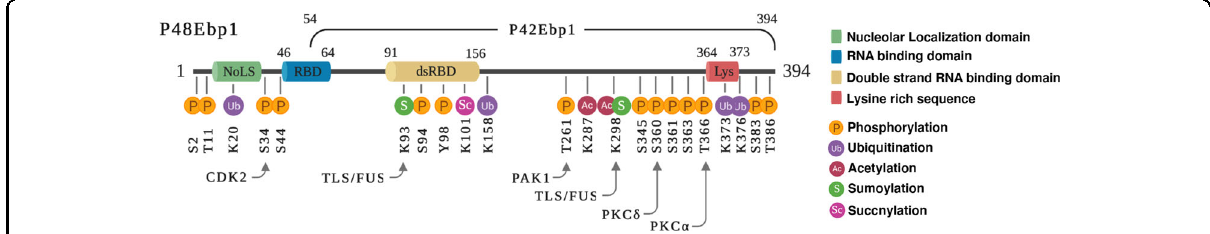
Fig. 2 Protein structure and modi fi cations of EBP1 isoproteins. The two EBP1 isoproteins, p48 (394 a.a, 48 kDa) and p42 (340 a.a, 42 kDa), undergo multiple post-translational modi fi cations: Cyclin-dependent kinase 2 CDK2; Fused in sarcoma/translocated in liposarcoma TLS/FUS; p21- activated serine/threonine kinase 1 PAK1; Protein kinase C